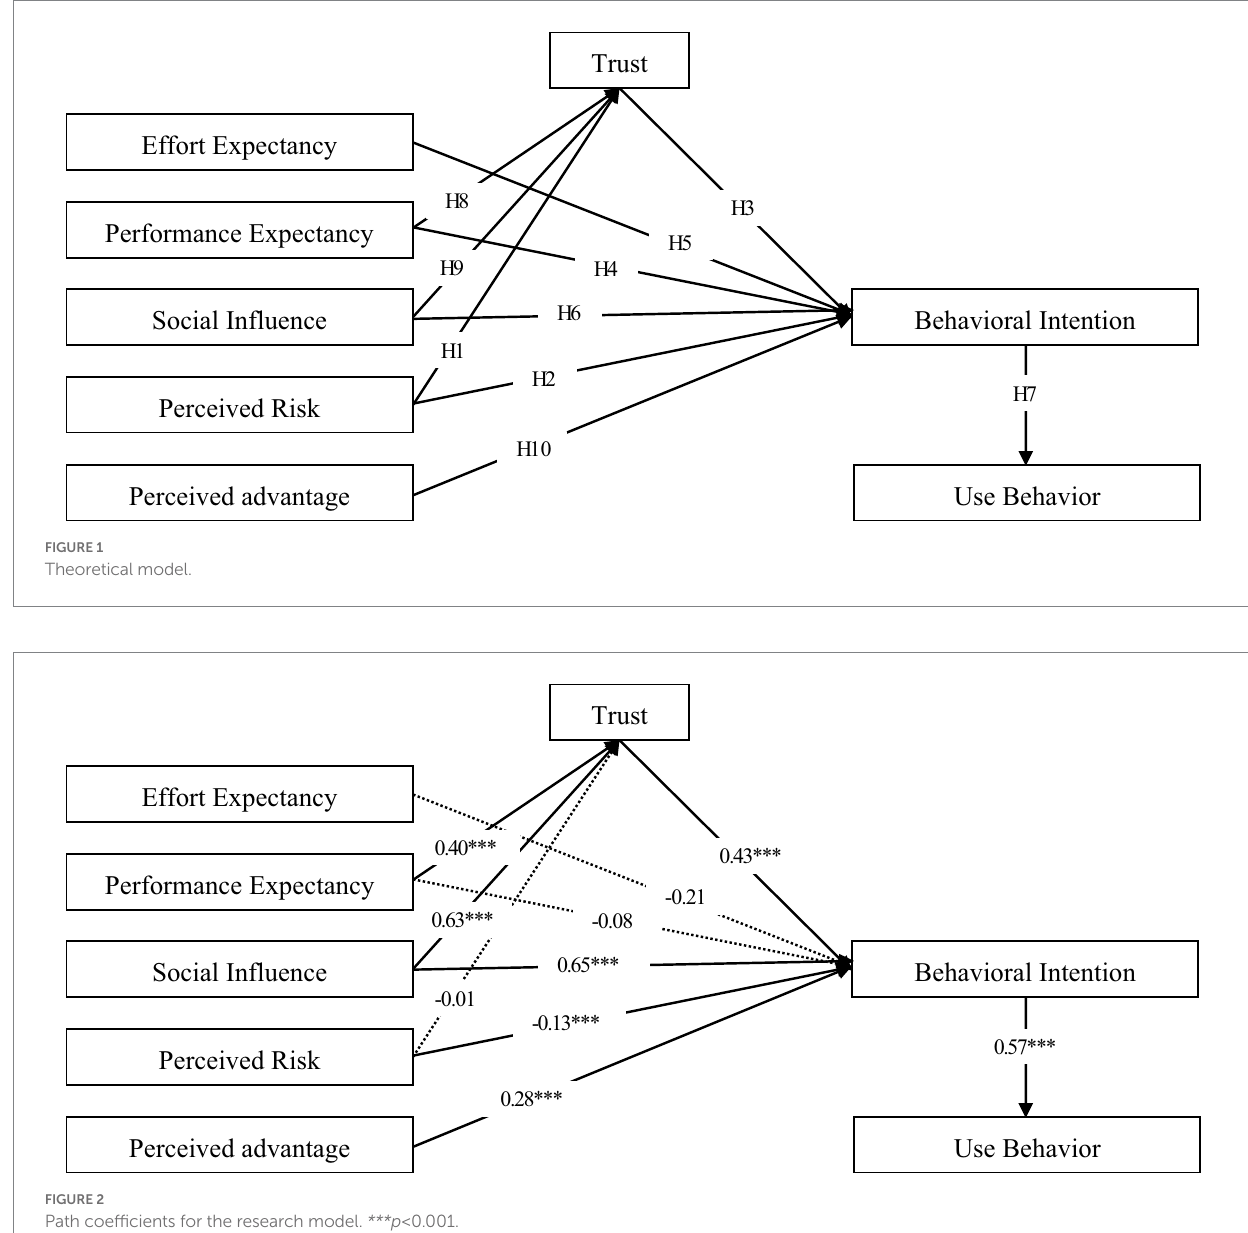
FIGURE 2 Path coefficients for the research model. ***p <